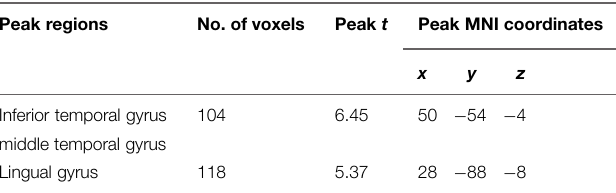
TABLE 2 | Significant activations for participants’ own faces compared to neutral faces between anorexia nervosa (AN) and control participants, Own > Neutral, AN > Healthy